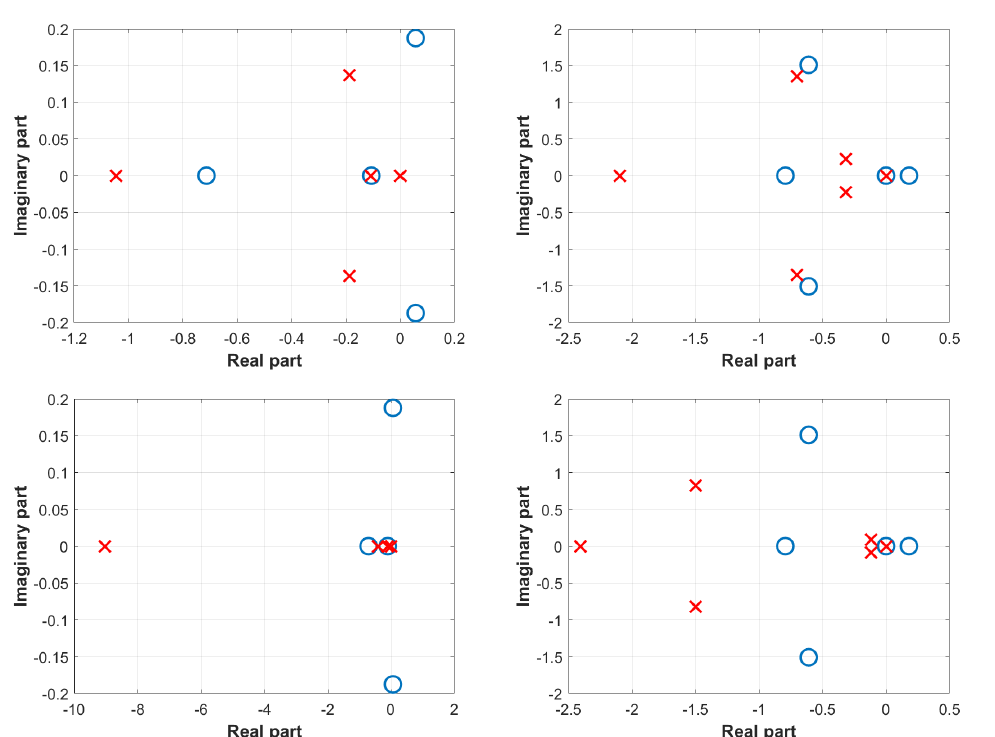
Figure 7. Maps of eigenvalues for free (blue circles) and artificially stabilized (red crosses) systems, trim speed 8 m/s. Left : longitudinal dynamics. Right : lateral-directional dynamics. Top row : layout (A). Mid row : layout (B). Bottom row : layout (C).